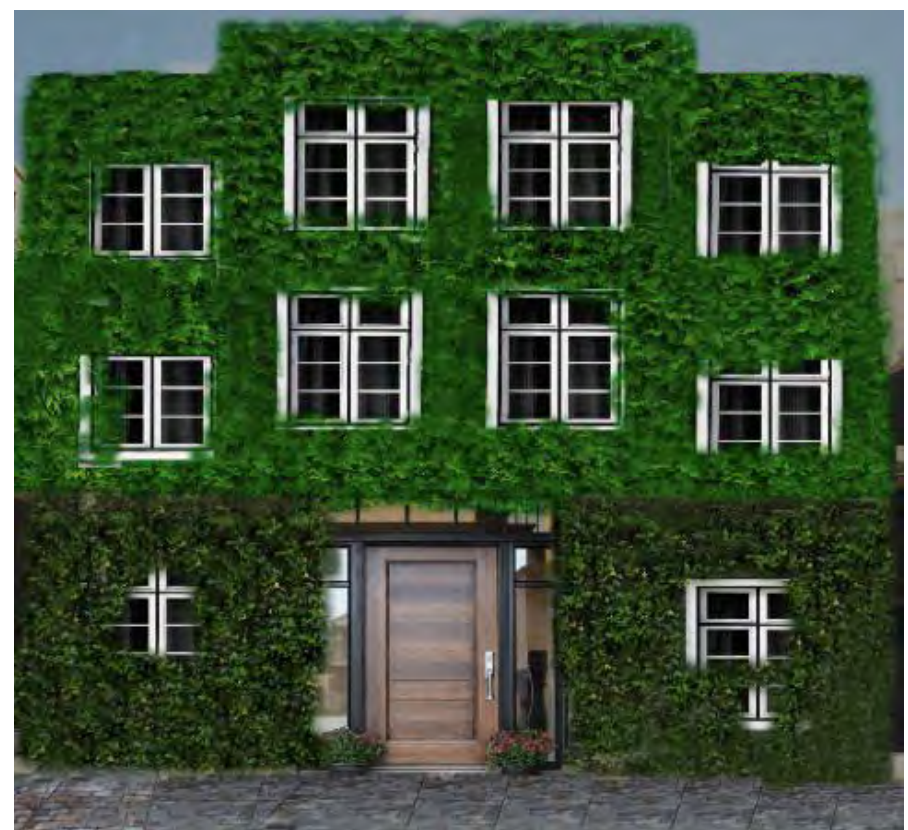
Fig. 34: Building facades with vertical